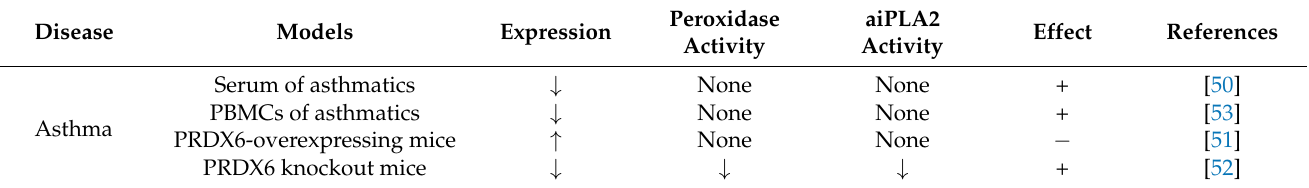
Table 1. PRDX6 expression and activity changes in asthmatics and different models.